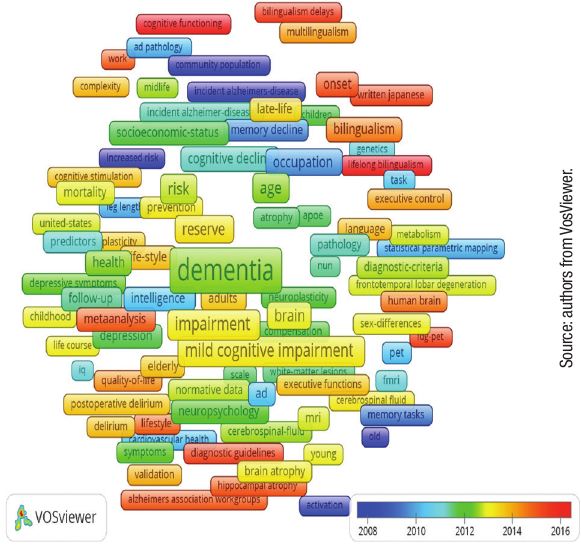
Figure 1. Network of keywords